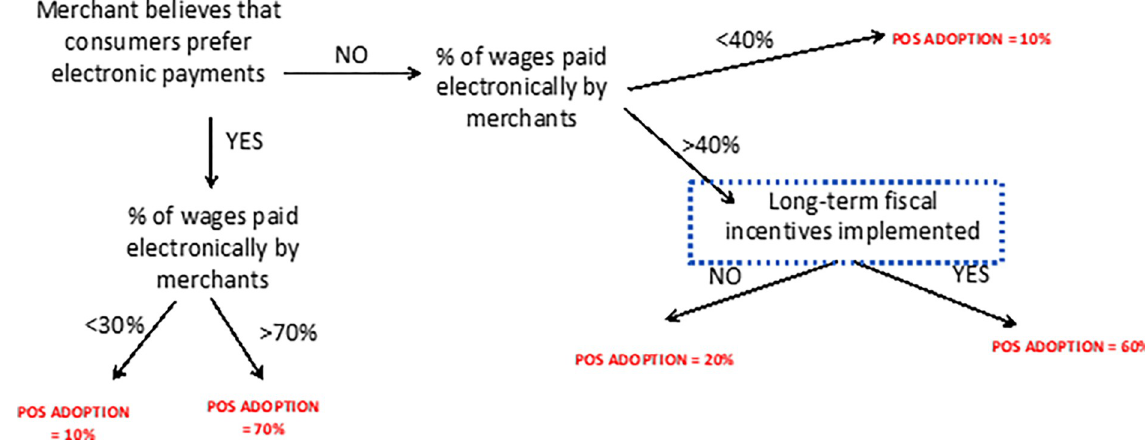
Fig 1. Example of a conditional classification tree. Note: This conditional inference tree is obtained from a merchant-sample estimation using the parameters provided by the variable importance plot from the random forest.